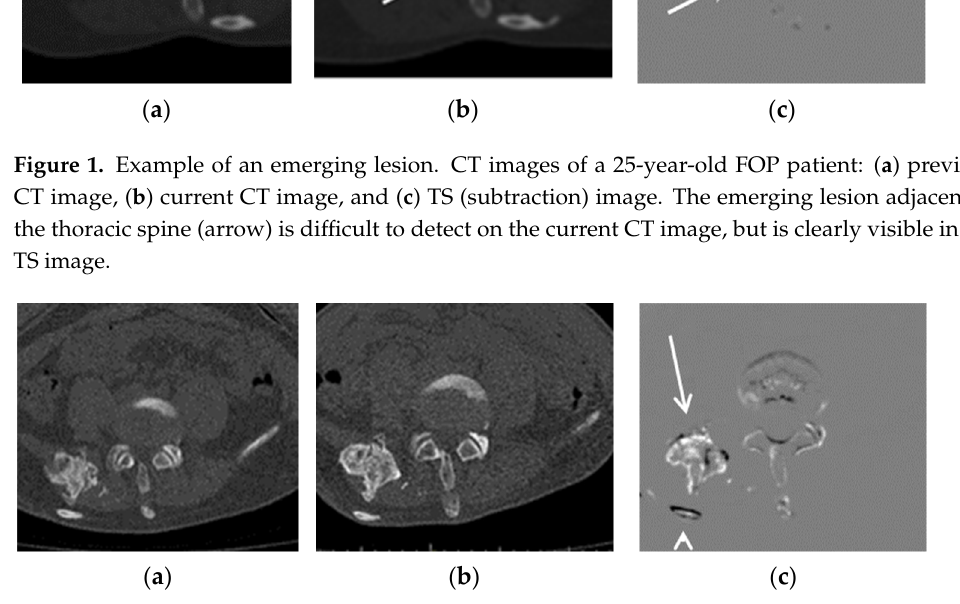
Figure 2. Example of a growing lesion. CT images of a 16-year-old FOP patient: ( a ) previous CT image, ( b ) current CT image, and ( c ) TS (subtraction) image. The growing lesion near the ilium (arrow) is difficult to detect in the current CT image, but is clearly visible in the TS image. The dorsal rib of this lesion (arrowhead) is shown due to misregistration.